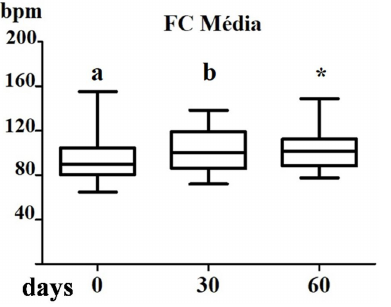
Figure 7. Comparison between the mean values in beats per minute (bpm), as a function of days, regarding the Average Heart Rate (HR) value, before and after rhinoplasty surgery. Different letters (“a” and “b”) along the one of the columns indicate significant difference at 5% level. Asterisks (*) along the same line indicate no statistical difference at the 5%